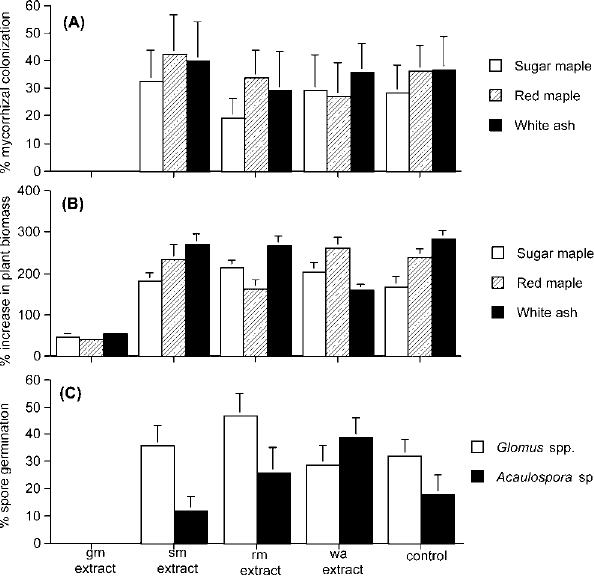
The effects of extract of garlic mustard (gm), sugar maple (sm), red maple (rm), white ash (wa), or a water control on (A) mycorrhizal colonization of native tree seedlings ( F sugar maple ¼ 20.3, df ¼ 4,49, p , 0.001; F red maple ¼ 19.8, df ¼ 4,49, p , 0.001; and F white ash ¼ 25.4, df ¼ 4,49, p , 0.001 [Experiment 3]), (B) increase in biomass of native tree seedlings ( F sugar maple ¼ 11.7, df ¼ 4,49, p , 0.001; F red maple ¼ 14.2, df ¼ 4,49, p , 0.001; and F white ash ¼ 27.9, df ¼ 4,49, p , 0.001 [Experiment 3]), and (C) percent germination of native AMF spores ( F Glomus ¼ 17.3, df ¼ 4,49, p , 0.001; and FA caulospora ¼ 21.8, df ¼ 4,49, p , 0.001 [Experiment 4]). Bars represent the mean and standard error. DOI: